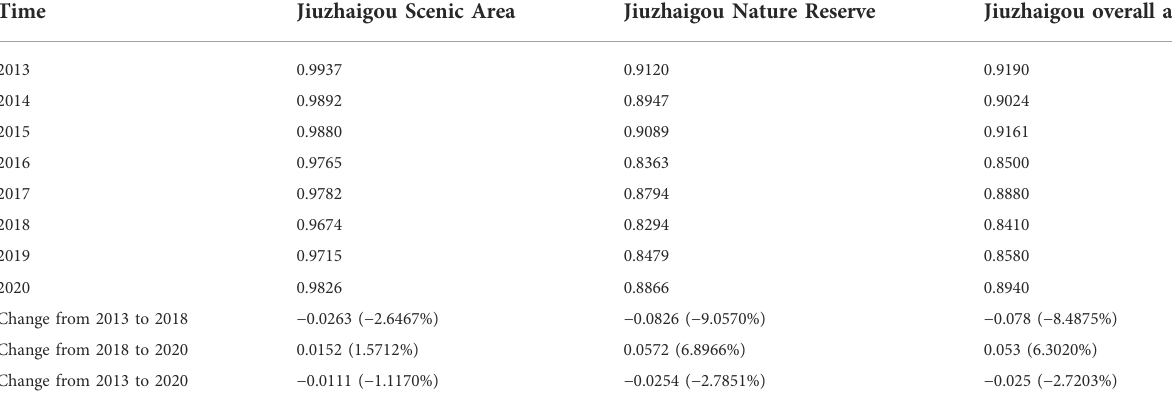
TABLE 8 The change of the Habitat Quality Index in Jiuzhaigou from 2013 to 2020.